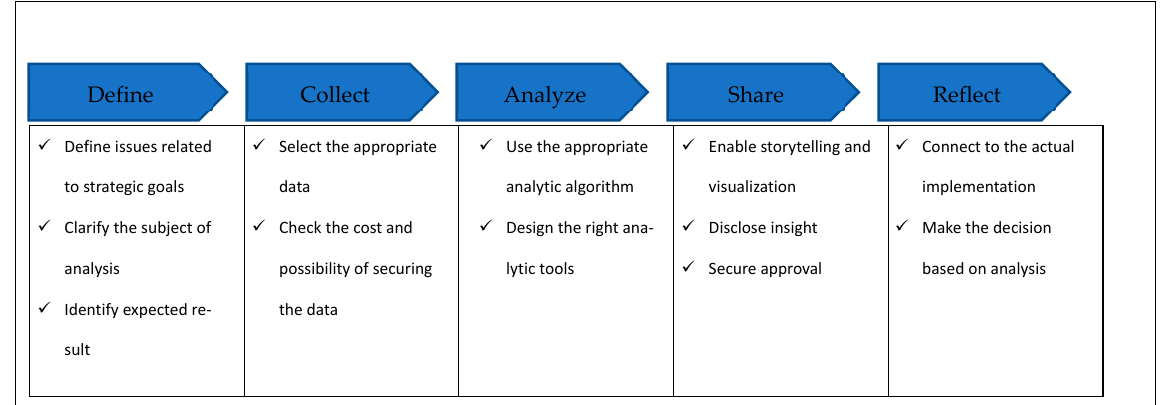
Figure 1. Common Elements of HR Analytics Processes.